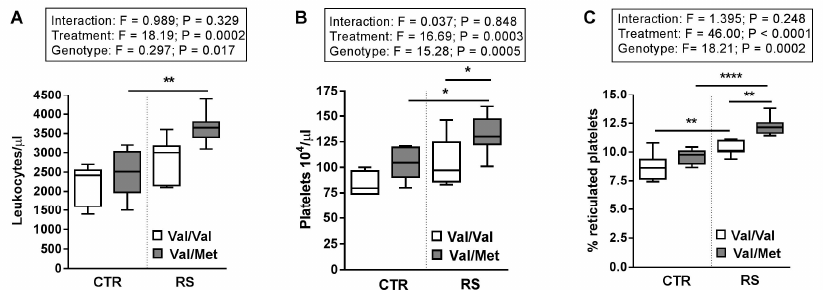
Figure 3. Circulating blood cell numbers are increased by restraint stress. ( A ) Numbers of circulating leukocytes, ( B ) platelets were counted, and ( C ) the percentage of reticulated platelets were analysed by flow cytometry in stressed (RS) and not stressed (CTR) BDNF Val/Val and BDNF Val/Met mice. n = 6 mice/group. Two-way ANOVA followed by Bonferroni post hoc analysis, p values were obtained by using log-transformed variables. * p < 0.05, ** p < 0.01 and **** p < 0.001. For each box-plot, the center line illustrates the median and box limits indicate the 25th and 75th percentiles.